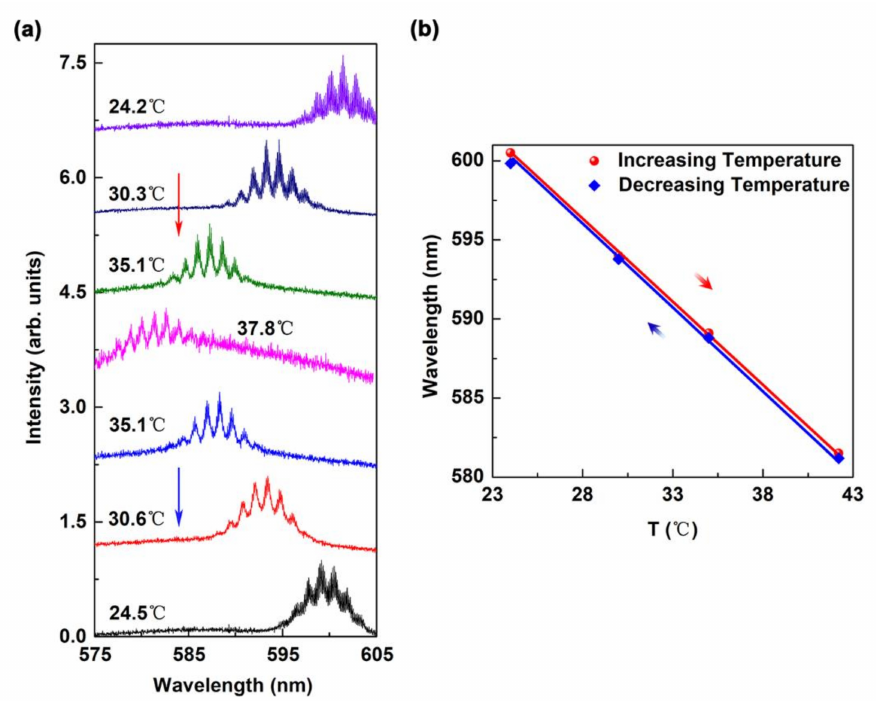
Figure 5. Reversibility of the continuously tunable WGM laser device. ( a ) Lasing spectrum as a function of cycled ambient temperature. ( b ) The emission wavelength as a function of temperature. The blue symbols and line denote a decreasing temperature and the red symbols and line denote an increasing